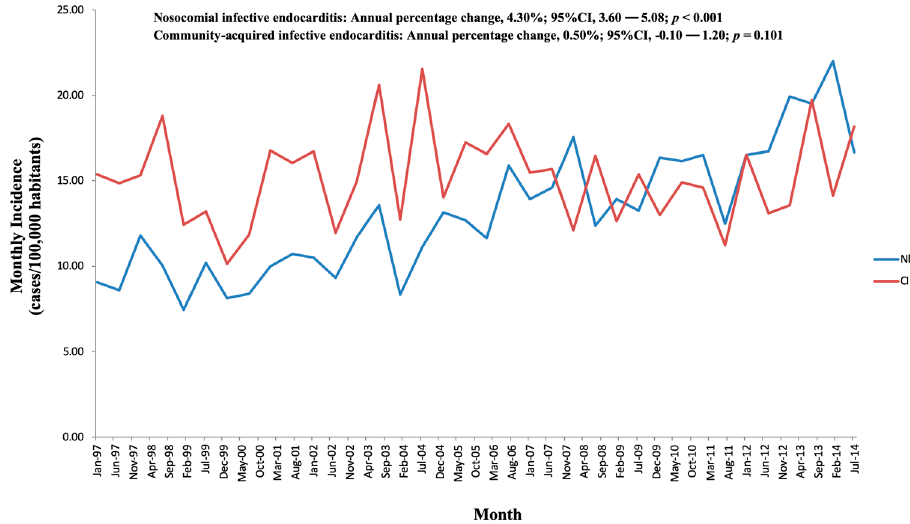
Figure 4. Incidence of infective endocarditis classified by nosocomial infective endocarditis and community-acquired infective endocarditis from 1997 to 2014 in Spain.